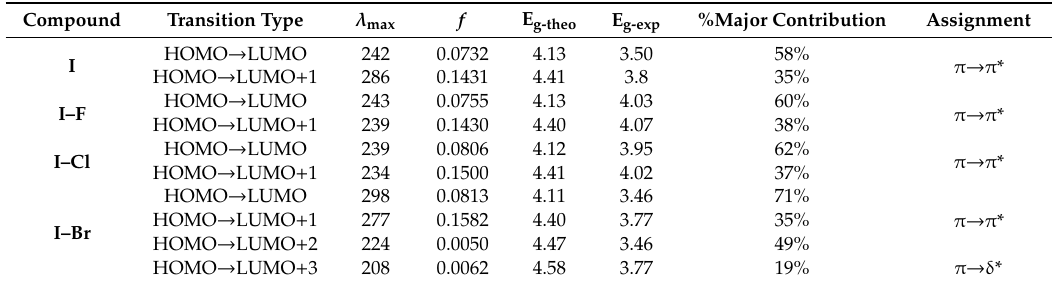
Table 6. Calculated maximum absorption wavelengths λ max (nm), oscillator strengths (f), transition energy (E g-theo , eV), experimental transition energy (E g-exp , eV),% of contribution, and assignment of I , I − F , I − Cl , and I − Br compounds. Calculated results at TD-PBE1PBE / 6-311G(d,p) theory level. Compound Transition Type λ max f E g-theo E g-exp %Major Contribution